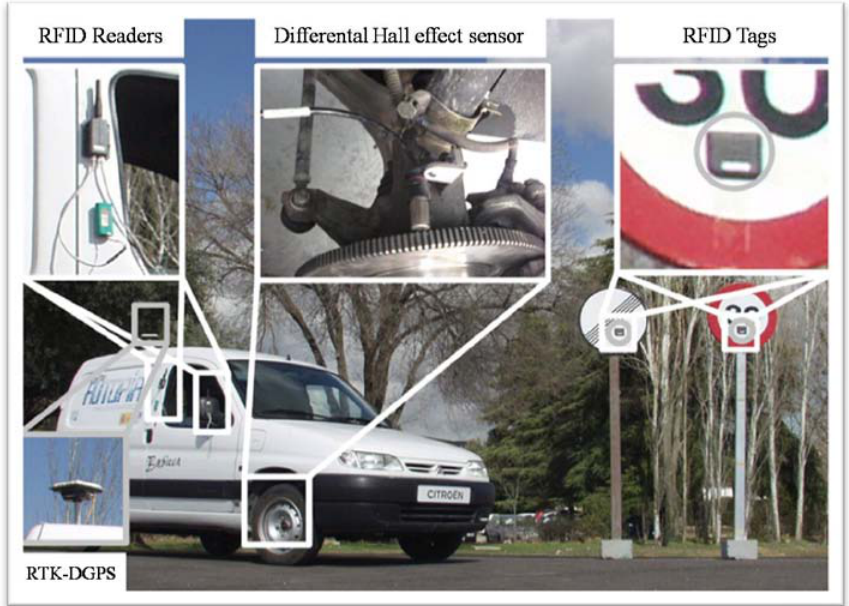
Figure 1. Sensors installed in the vehicle for the CC experiments: GPS unit, RFID readers and a speed measurement system based on a differential Hall Effect sensor mounted in a cogwheel (left-hand side). Traffic signals equipped with the RFID tags (right-hand